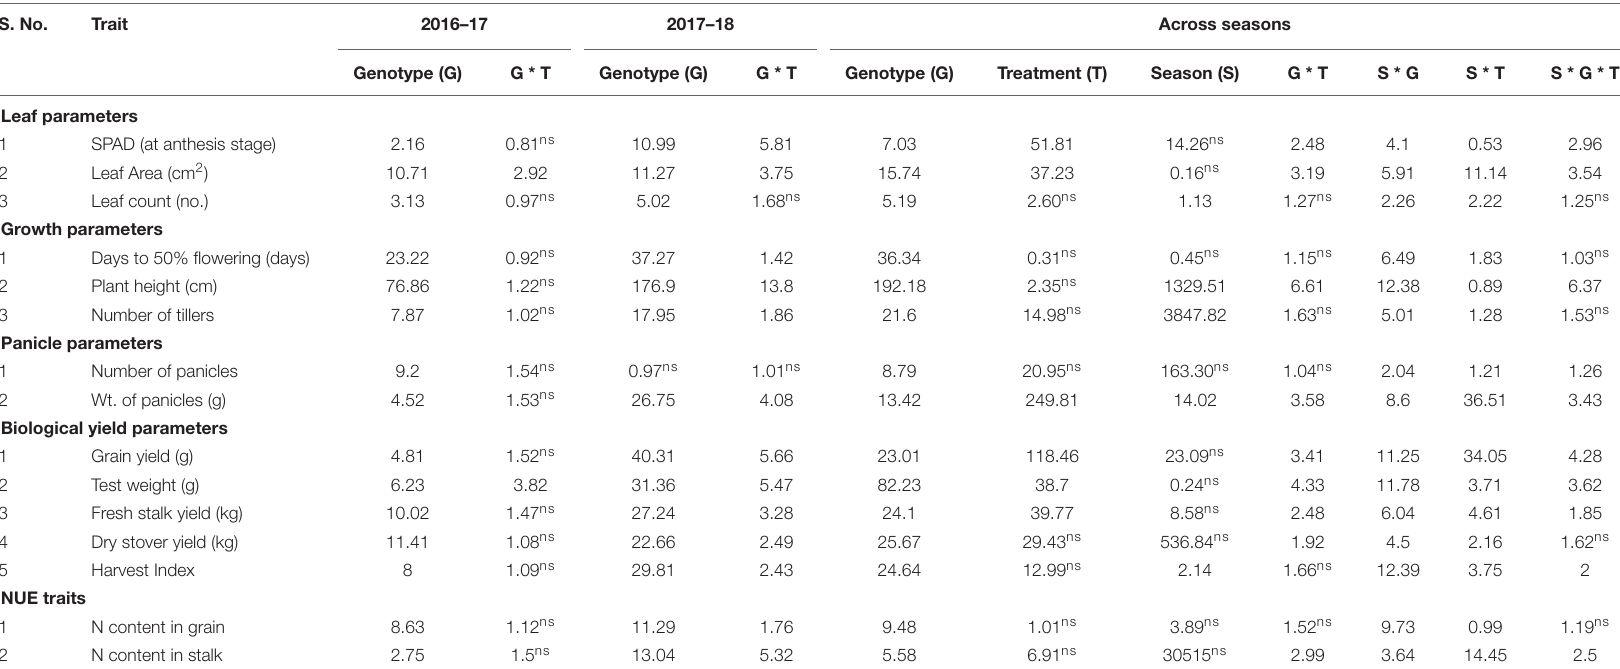
TABLE 2 | Summary of ANOVA for leaf, growth, panicle, biological yield parameters along with NUE traits under three N dosages in field for the season 2016–17, 2017–18, and across seasons. S.